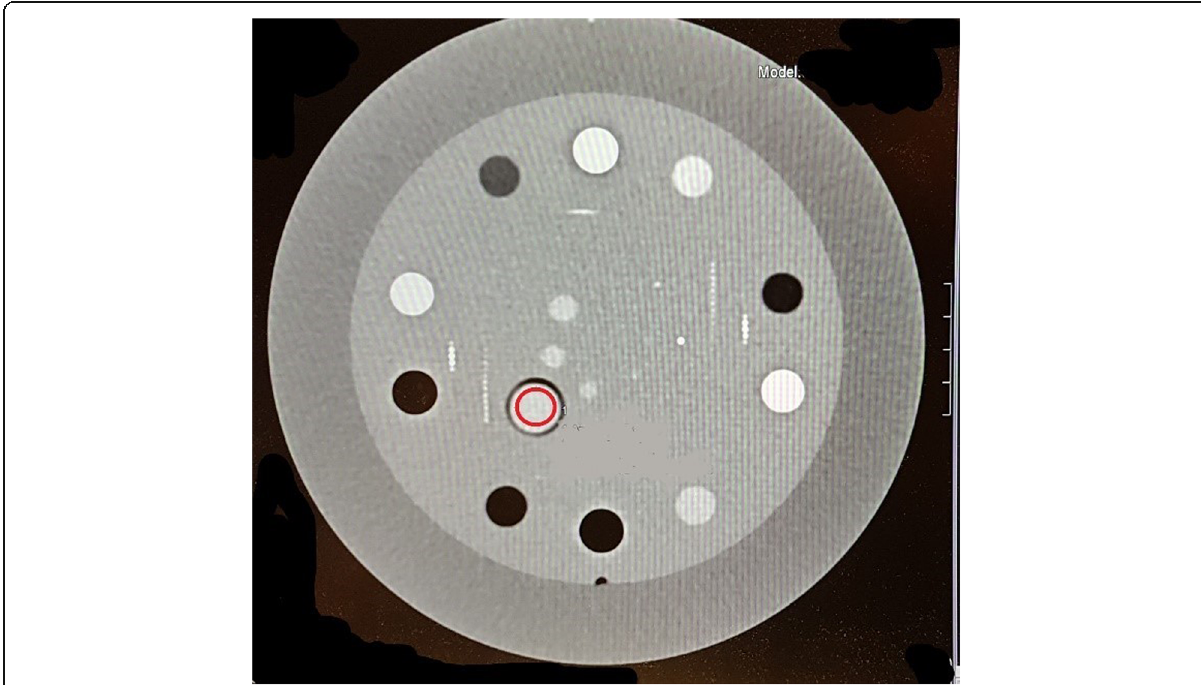
Fig. 1 The Catphan CTP682 phantom was positioned in the isocentre of the gantry. The regions of interest were placed in the centre of the iodine solution in the phantom, here visualised as a red ring in the image